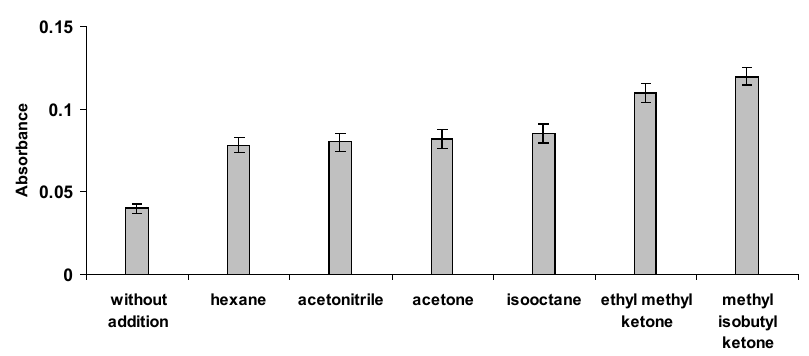
Figure 3. Influence of hexane, acetonitrile, acetone, isooctane, ethyl methyl ketone and methyl isobutyl ketone on absorbance of